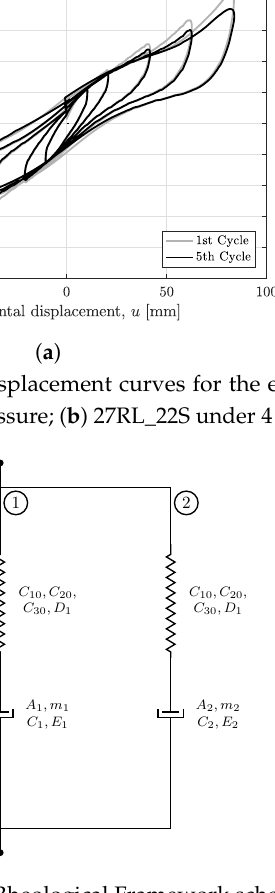
Figure 3. Parallel Rheological Framework